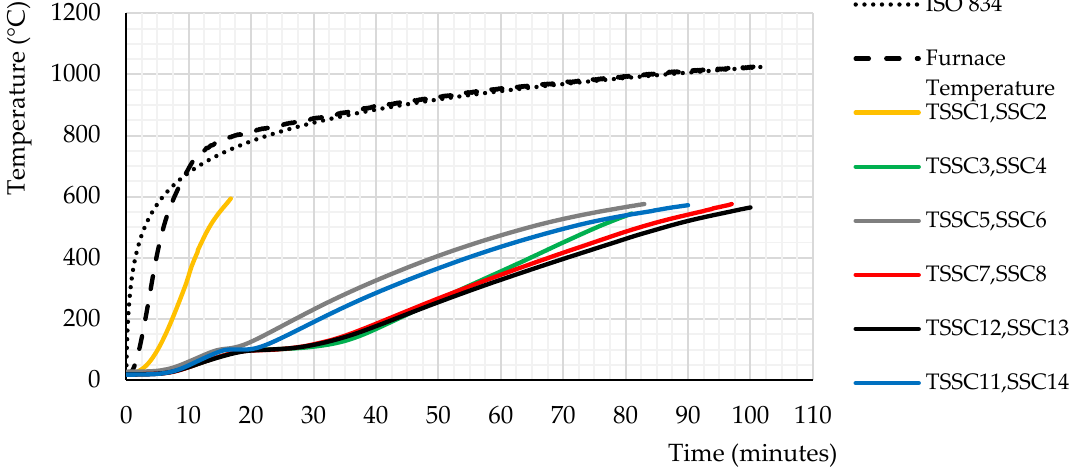
Figure 13. Evolution of temperature in the specimens of SSC as a function of time.